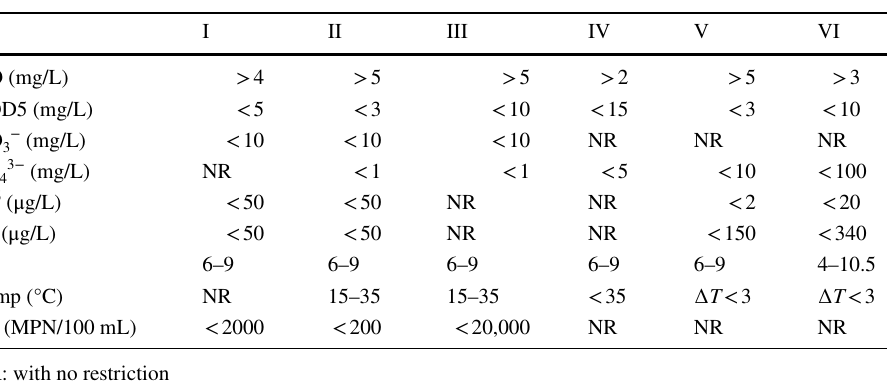
Fig. 1 Map of Buenos Aires City and the sampling sites (Mapoteca